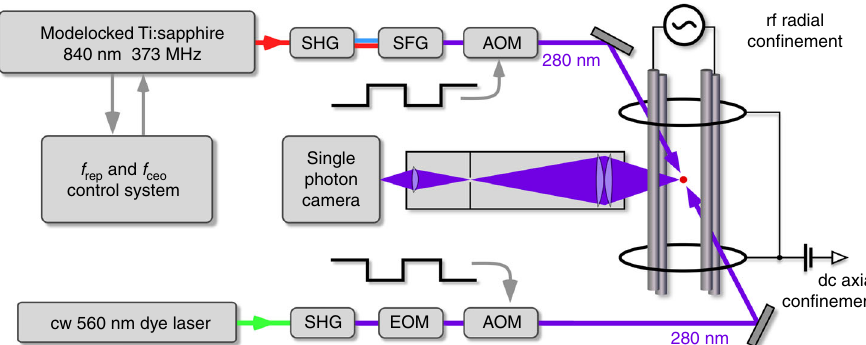
Fig. 1 Experimental setup schematic. A frequency doubled cw dye laser is used for laser cooling trapped Mg ions on the 3 s 1/2 − 3 p 3/2 transition. The same transition is interrogated with an individual mode of the UV frequency comb that derives from the third harmonic of a Ti:sapphire mode locked laser and is spatially overlapped with the cw laser. The two lasers are alternatingly turned on for 2 ms with two acousto optic modulators (AOM). Thanks to its lower power, detuning dependent residual heating/cooling due to the near resonant mode of the comb is largely suppressed (see text). The fl uorescence signal is detected by spatially resolved single photon camera during the bright times of the comb i.e. the dark periods of the cooling laser. The ion trap consists of four rf-electrodes, two pairs of ring electrodes for axial con fi nement and four rod-like dc-electrodes (not shown) for stray fi eld cancellation.